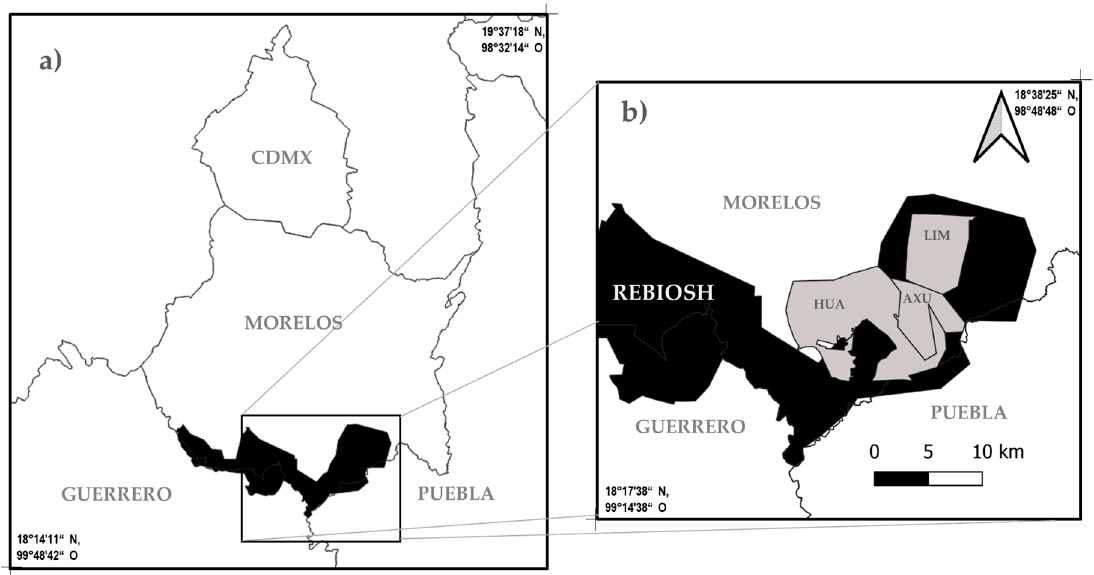
Figure 1. Location of: ( a ) Morelos state in central Mexico and the Sierra de Huautla Biosphere Reserve (REBIOSH) in Morelos (black polygon); ( b ) location of the three ejidos where the study was done (dark gray polygons; AXU = Ajuchitlán; HUA = Huautla; and LIM = El Limón de Cuauchichinola) within the REBIOSH, in southern Morelos.